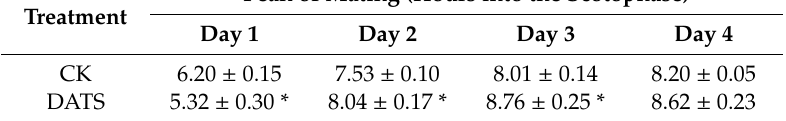
Table 1. E ff ects of diallyl trisulfide (DATS) on peak of mating of Sitotroga cerealella where CK is the control